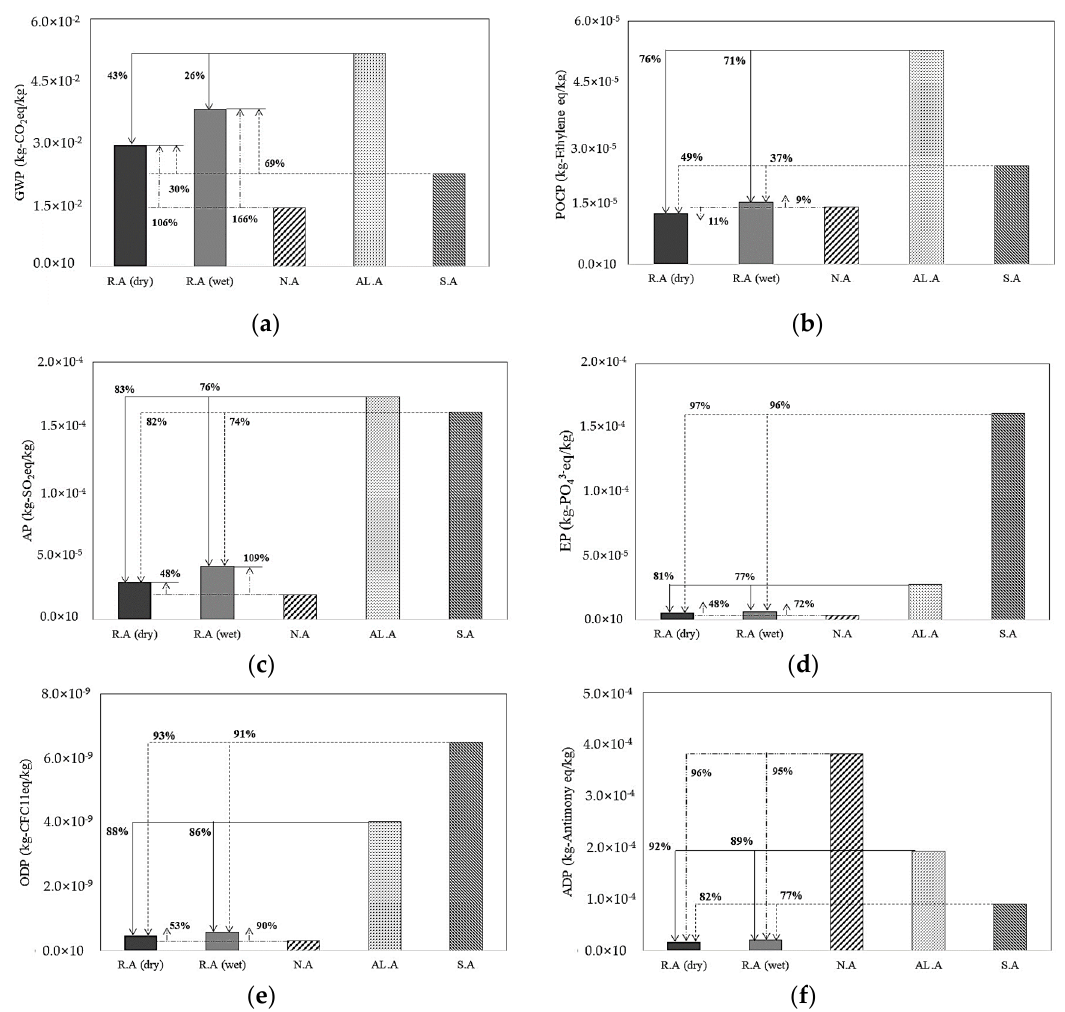
Table 5. Environmental impact comparison by aggregate type.